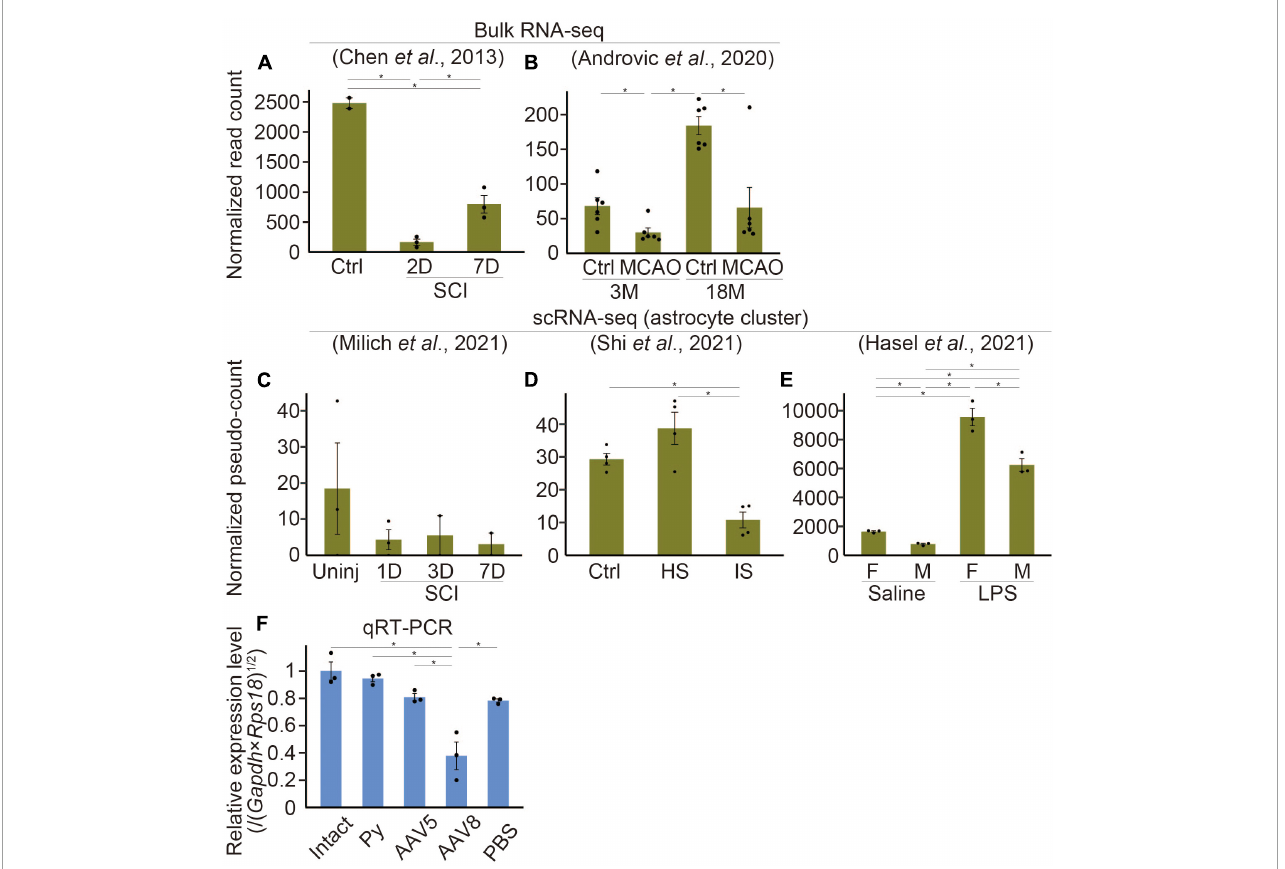
FIGURE2 Etnppl -expression in several kinds of diseases. (A–E) Expression levels of Etnppl in bulk RNA-seq (A,B) or scRNA-seq (C–E) datasets. Vertical axes represent normalized read counts of Etnppl in the tissue (A,B) or normalized pseudo-counts in the astrocyte cluster (C–E) . ∗ P < 0.05, Wald test. Ctrl, control; D, days after injury; 3M, 3 months of age; Uninj, uninjured; HS, hemorrhagic stroke; IS, ischemic stroke; F, female; M, male. (F) Expression level of Etnppl in the cervical cord 2 weeks after AAV infection as revealed by qRT-PCR. The vertical axis represents the relative expression level of Etnppl normalized by the geometric mean of Gapdh and Rps18 , taking the value of the intact group as one. ∗ P < 0.05, Tukey’s HSD test. Mean ± S.E.M. n is equal to the number of dots in each